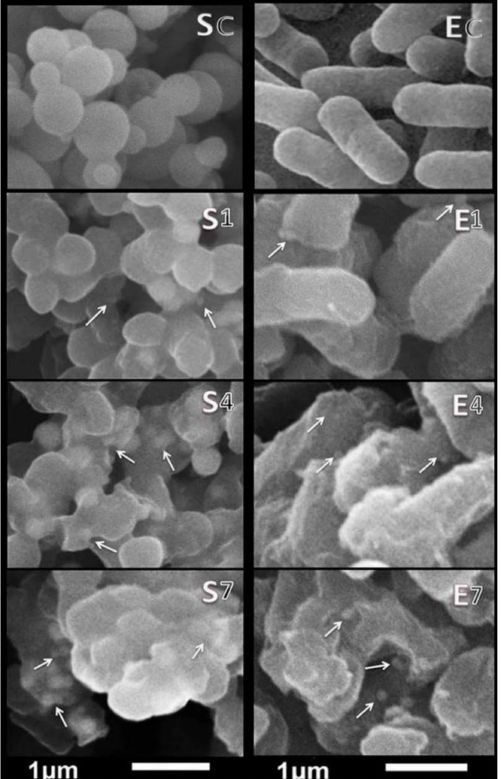
Figure 6. Scanning micrographs of treated Staphylococcus aureus (left) and Escherichia coli (right) with phycosynthesized UFD-ZnONPs after 1 h ( S1 , E1 ), 4 h ( S4 , E4 ), and 7 h ( S7 , E7 ), compared with non-exposed bacteria ( SC , EC ). * Arrows indicate some of attached NPs to cell